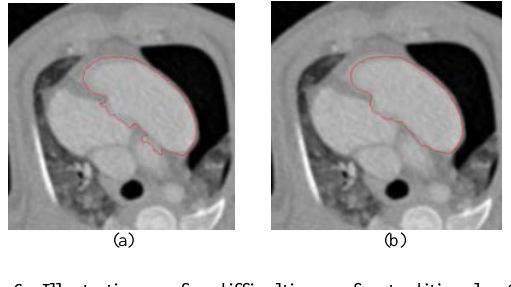
Fig. 6. Illustration of difficulties of traditional CV segmentation method. (a) boundary-leak, (b)incomplete